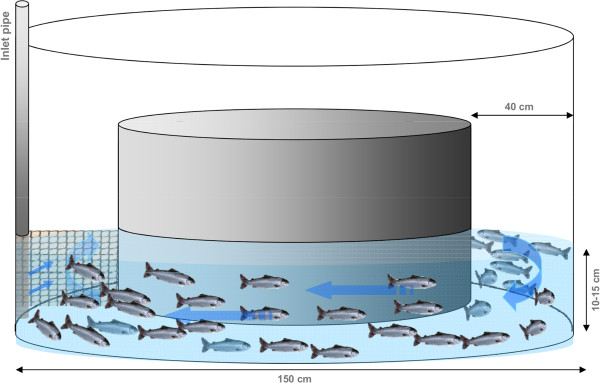
Swimming performance screening test. Groups of approx. 100 fish were placed in the screening tank each time and allowed to acclimate for 15 minutes at minimum water speed before start of the water speed increments. A plastic mesh (left side) prevented fish from drifting backwards. Inner ring was lifted one centimetre with the help of PVC pieces (not on diagram) to allow water drainage into the centre of the tank where the main outflow was located. Blue arrows indicate direction of water flow (clockwise).